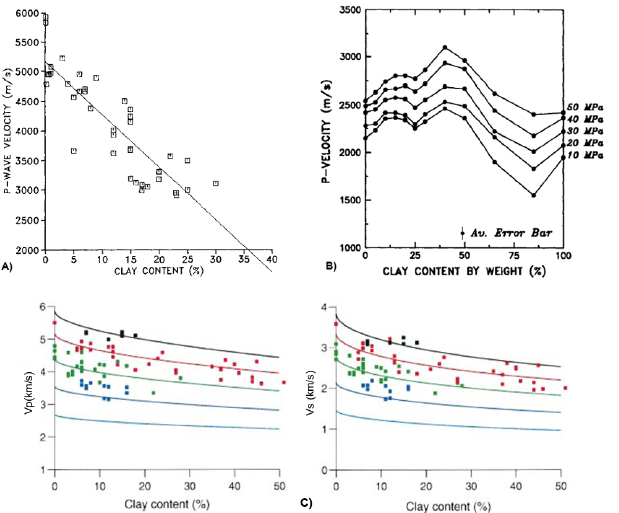
Fig. 3. Plots summarizing some literature studies on seismic veloc- ities versus clay content. Modified after Klimentos (1991) (plot A ), Marion et al. (1992) (plot B ) and Carcione et al. (2000) (plot C ).